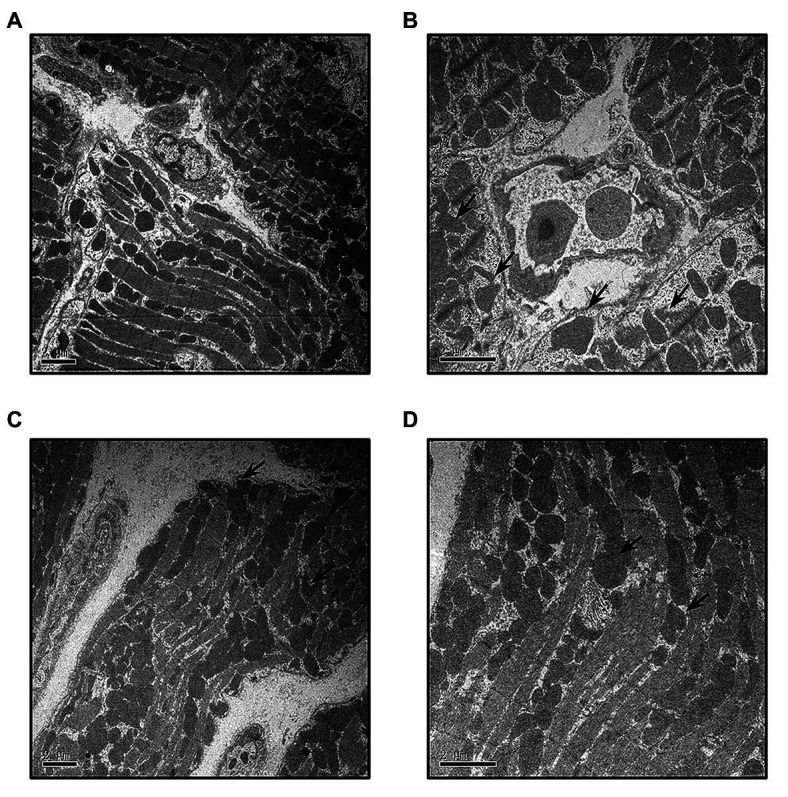
Myocardial ultramicroscopic results (2 μm). (A) Sham operation group; (B) control group; (C) sodium creatine phosphate group; and (D) Xinmailong group. Arrows in (B–D) indicate collagen and mitochondria fragments.